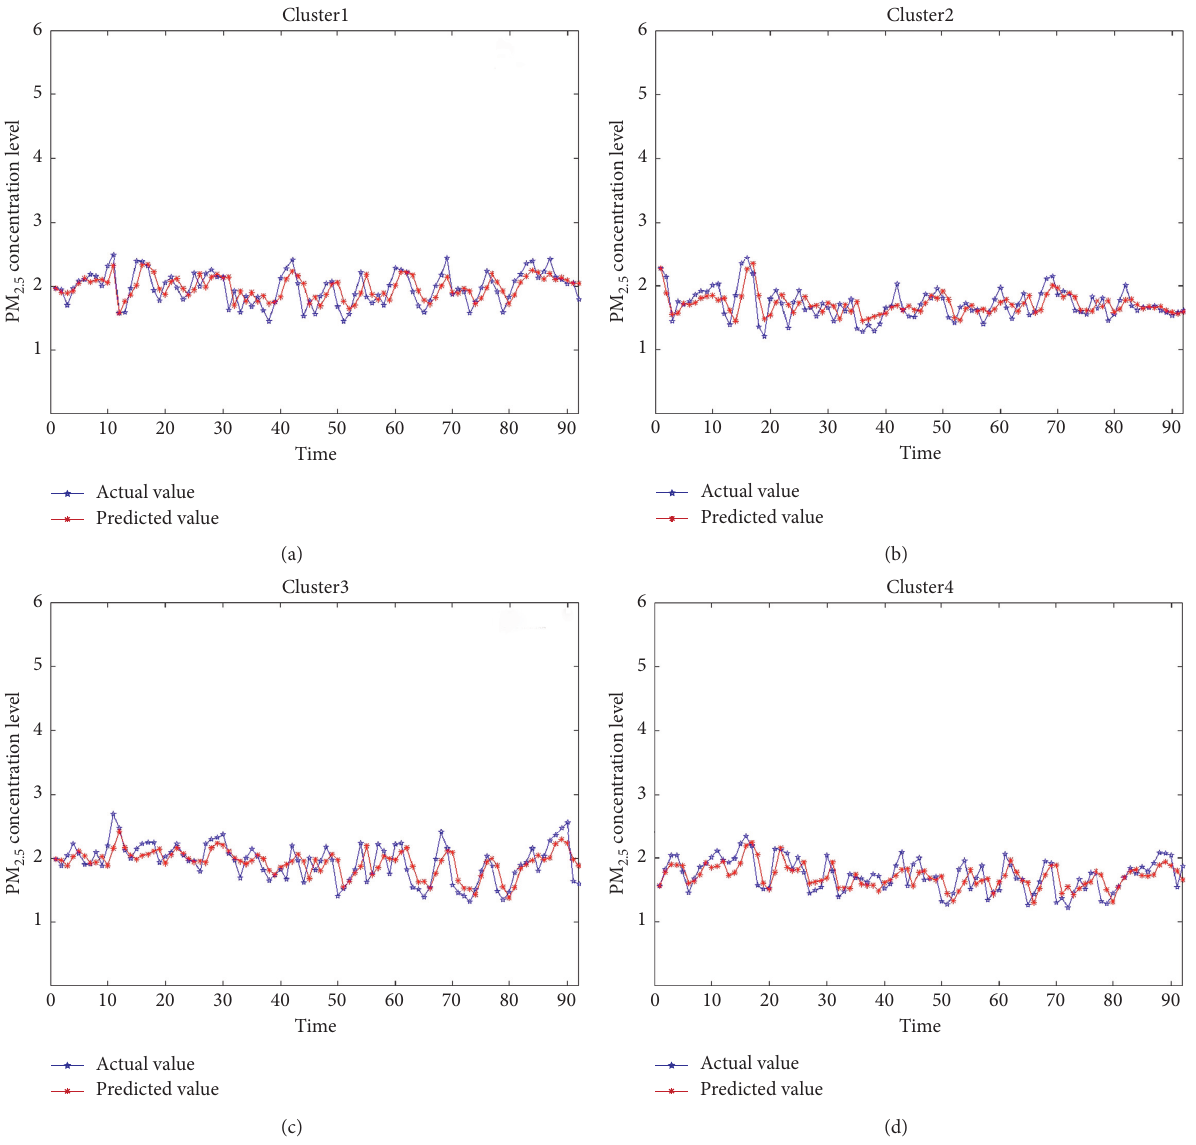
Figure 6: The daily PM2.5 concentration level from July 1, 2020, to September 30, 2020. Blue line represents the prediction value and red line stands for the real data: (a) Cluster1: D � 0.1196, α � 10 . 4835 , β � 2 . 0407 ; (b) Cluster2: D � 0.1266, α � 6 . 8230 , β � 1 . 5796; (c)